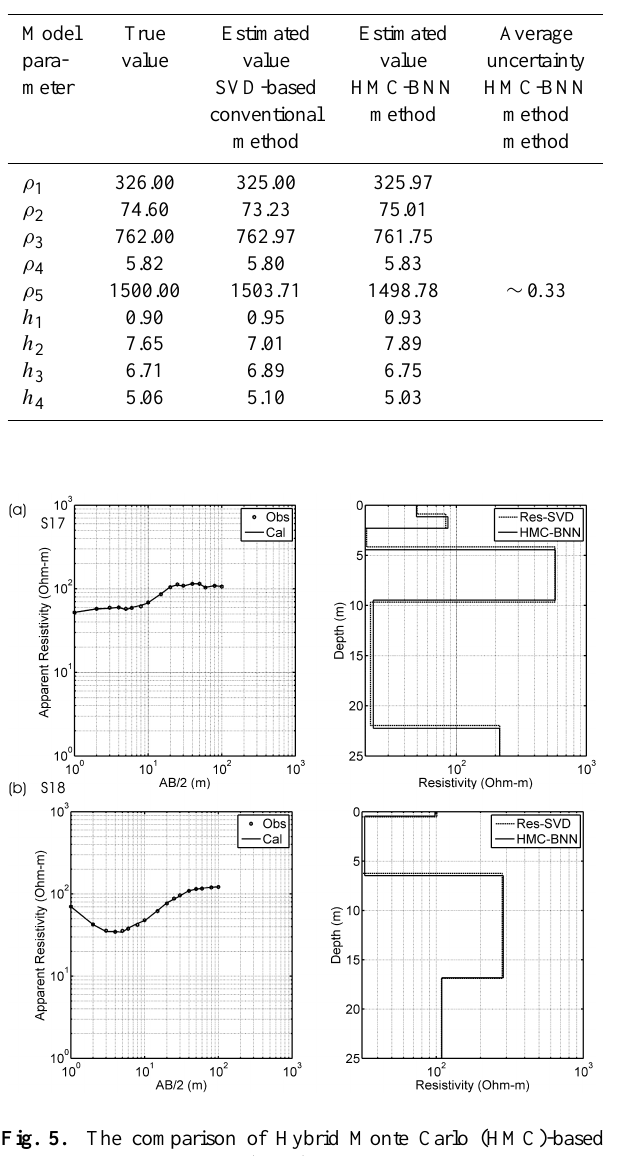
Fig. 5. The comparison of Hybrid Monte Carlo (HMC)-based Bayesian neural network (BNN) inversion results with singular value decomposition (SVD)-based conventional resistivity inver- sion results for soundings (a) s17 and (b) s18.